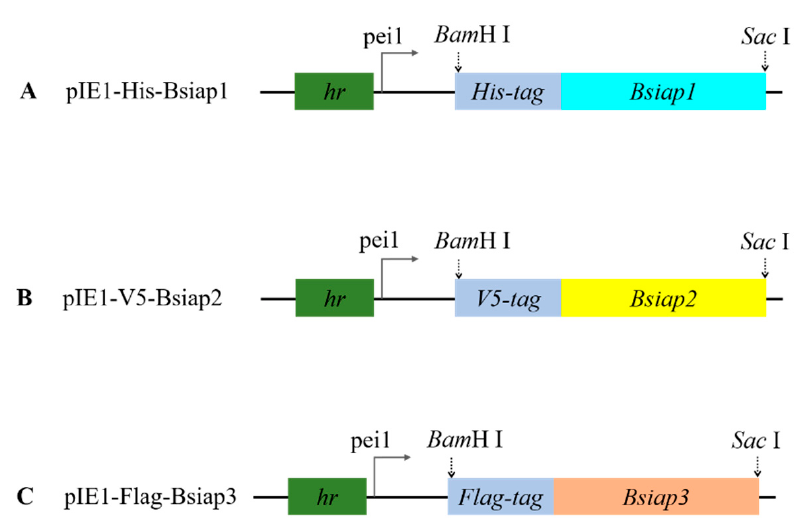
Figure 1. Construction of transient expression vector. Maps of the pIE1-His-Bsiap1 ( A ), pIE1-V5- Bsiap2 ( B ), and pIE1-Flag-Bsiap3 plasmids ( C ). The three plasmid constructs were transformed into E. coli DH5 α cells and plasmid DNAs were isolated using the Plasmid Miniprep Kit (Axygen, Corning, NY,